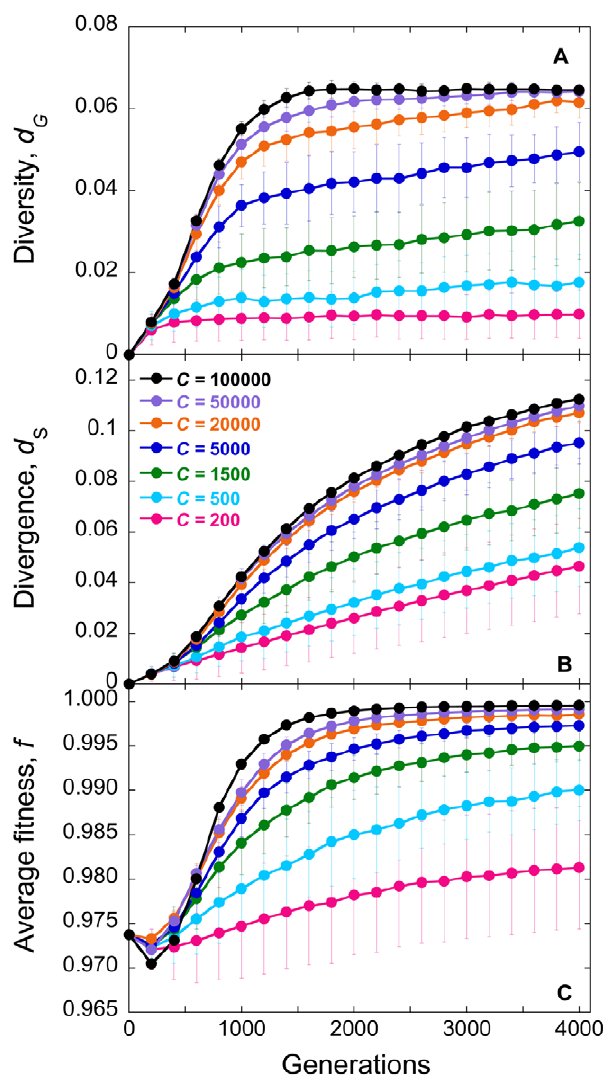
Figure 5. Simulations of viral genomic diversification with a low frequency of multiple infections. The evolution of (A) viral diversity, d G , (B) divergence, d S , and (C) average fitness, f , with generations predicted by our simulations for different population sizes, C . Each cell is assumed to be infected with M virions drawn from a distribution based on a viral dynamics model (see text). Error bars represent standard deviations.